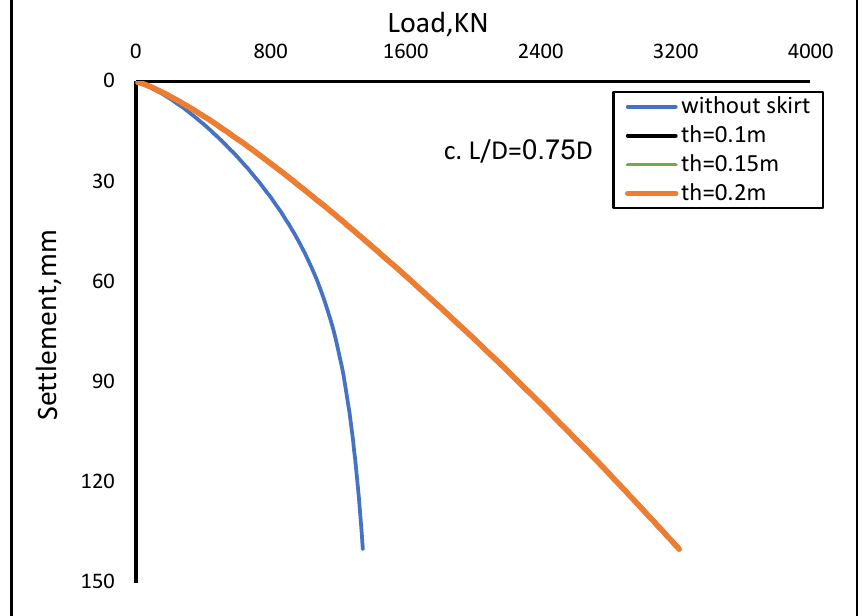
Fig. 5. Load-settlement relationship for skirt circular footing, L/D=0. 75.